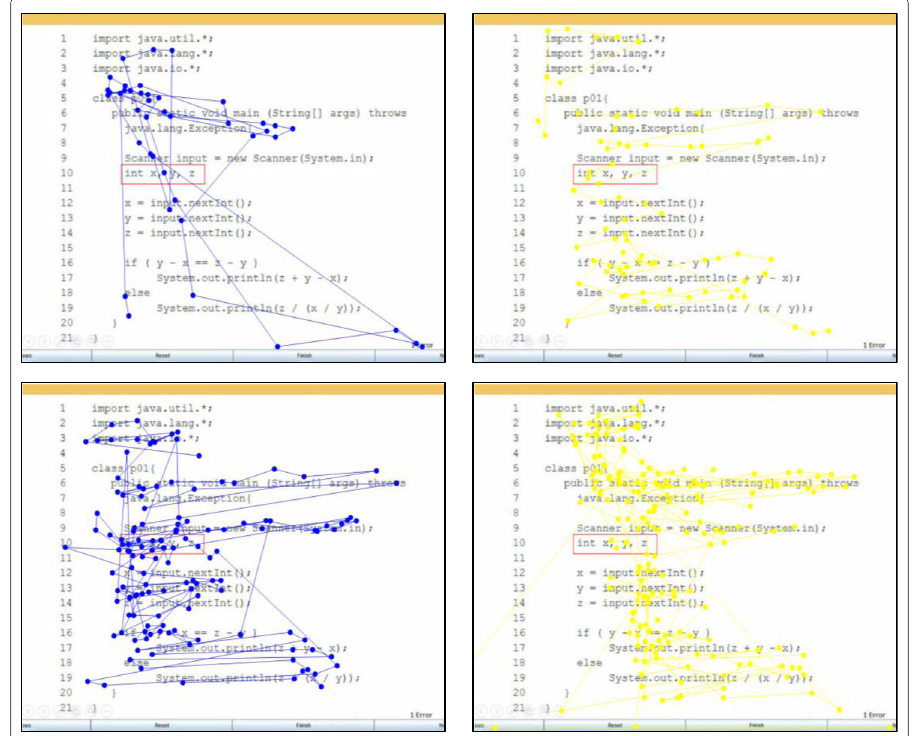
Fig. 8 Two pairs with dissimilar and similar scanpaths (top pair: left - more random, right - more linear; bottom pair: both almost linearly scan the program)